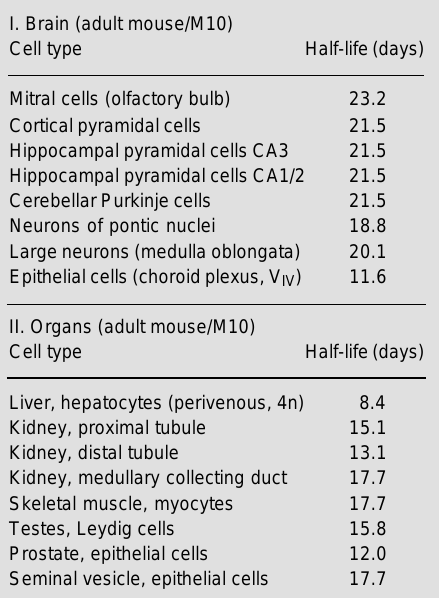
Table 1 - Half-lives of mitochondria within differ- ent cell types of the brain (I) and some body organs (II). M10, Ten months; 4n,